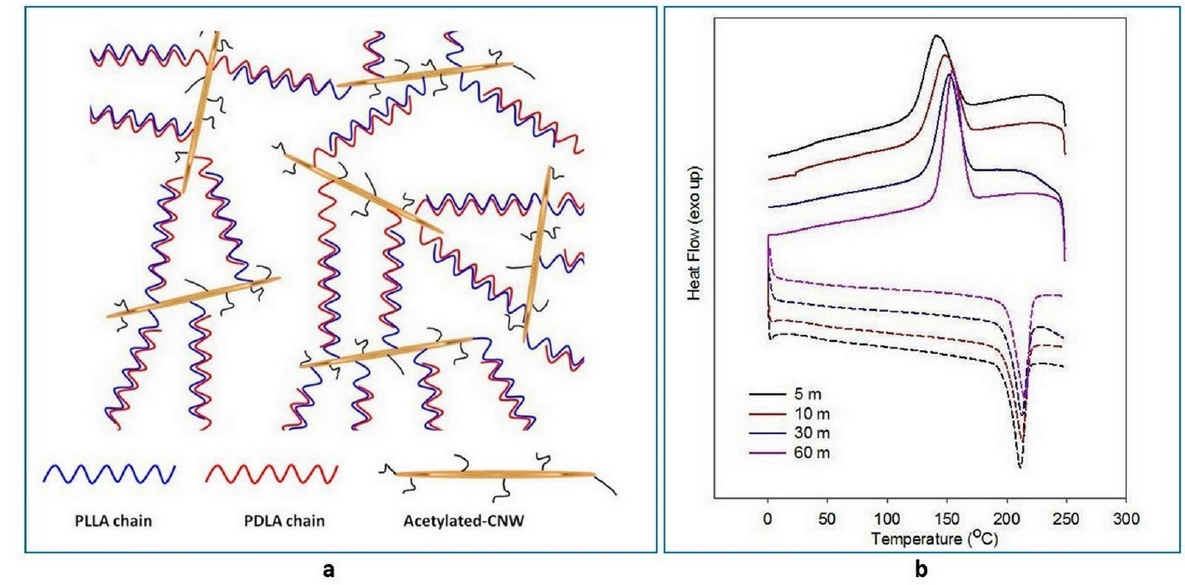
Figure 8. ( a ) Schematic structure of s-PLA–CNW via antiparallel re-assembles supported by graft- structure and well-distributed acetylated-CN; ( b ) DSC thermograms of bio-stereo-nanocomposites PLA–CNW at various processing times; cooling (solid-line) and second heating (dash-line). (Copy- right and permission, [29]).